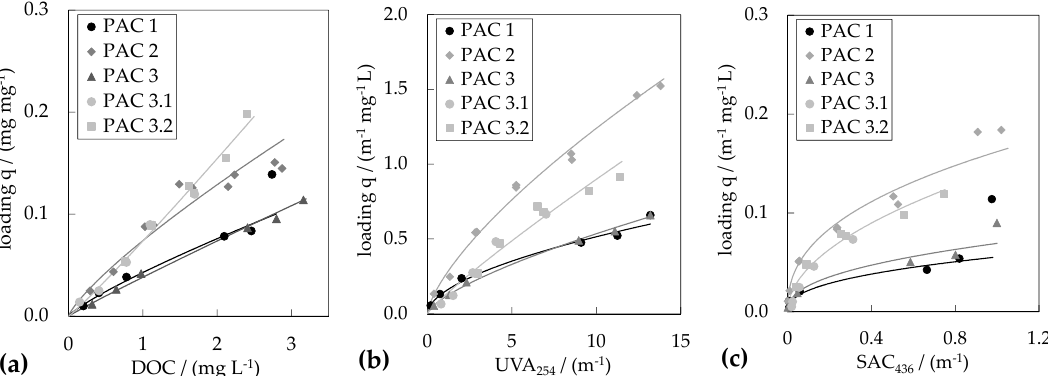
Figure 3. Adsorption isotherms of all tested PACs with respect to ( a ) DOC, ( b ) UVA 254 and ( c ) SAC 436 . Fitted Freundlich isotherms were added for PAC 1, PAC 2, PAC 3 and PAC 3.2 to guide the eye. (T = 20 °C, V batch = 200 mL, t R = 72 h at 150 rpm).